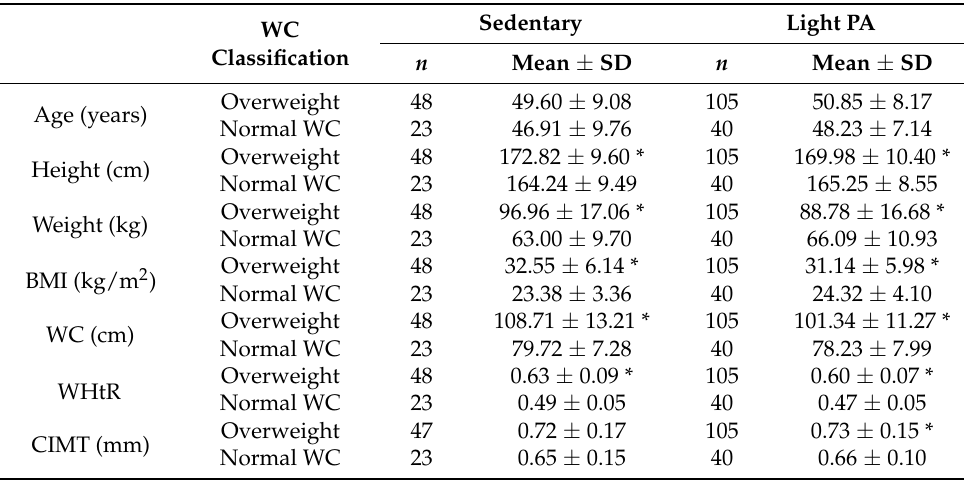
Table 2. Differences in descriptive characteristics of the teachers according to waist circumference classification.